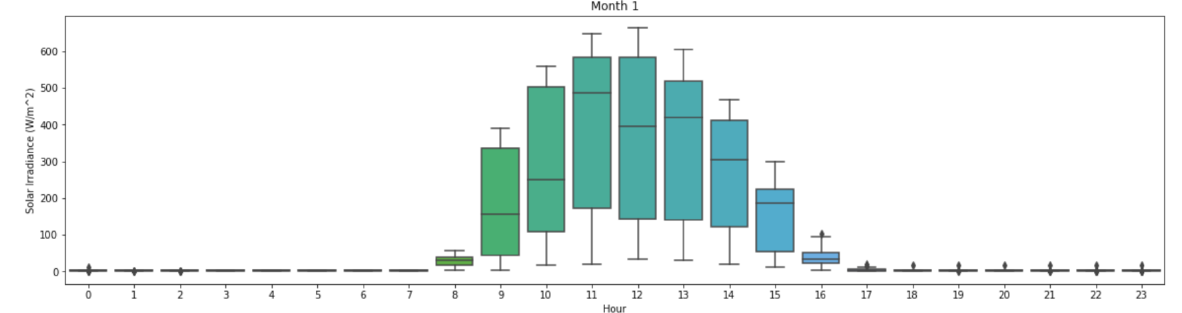
Figure 8. Box-whiskers plot for daily solar irradiance profiles for all days of January 2018 and 2019 (excluding the identified anomalous days).